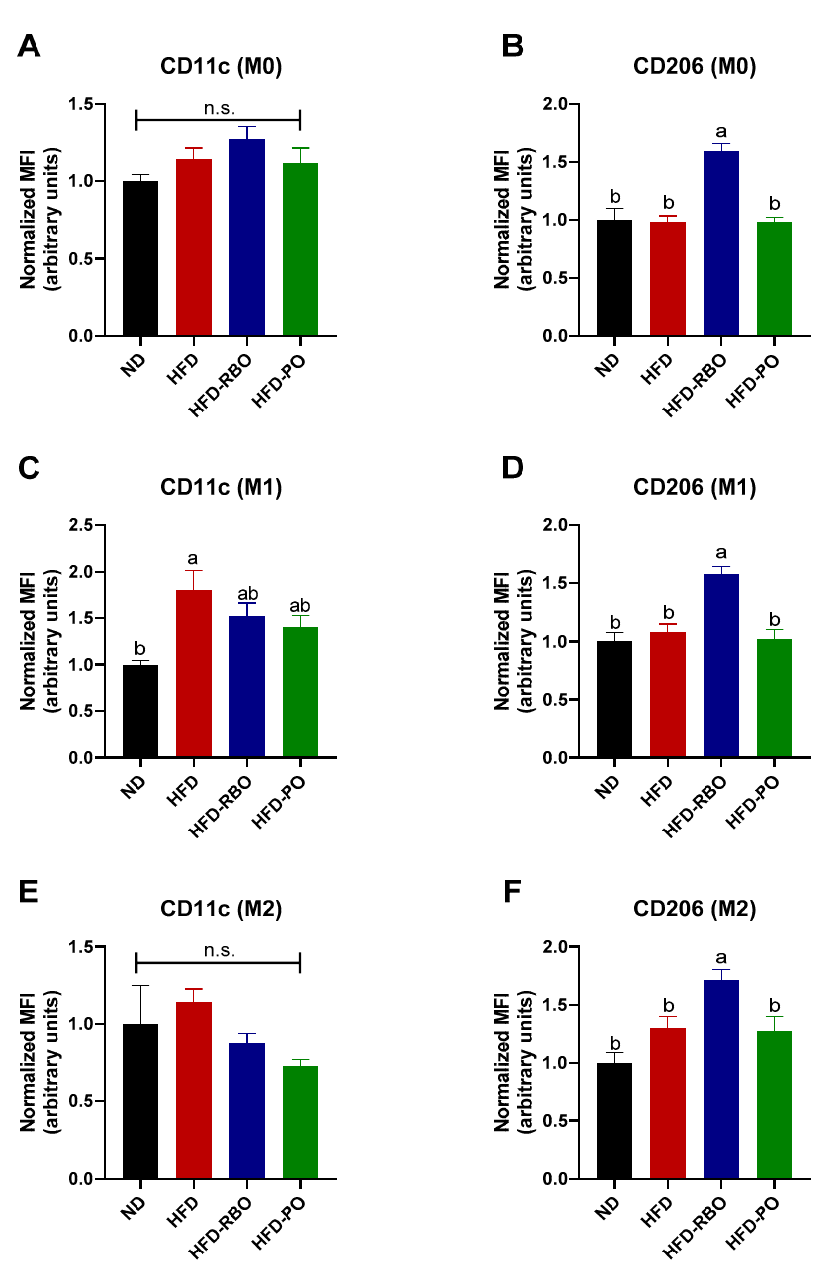
Figure 4. Expression of macrophage polarization markers in BMDMs. The BMDMs were stained with specific antibodies and mean fluorescence intensity (MFI) was assessed by flow cytometry. The F4/80 + CD11b + population cells were gated and designated as macrophages. The expression of ( A , C , E ) CD11c as an M1 marker and ( B , D , F ) CD206 as an M2 marker was further assessed in non-polarized (M0), polarized M1 BMDMs, and M2 BMDMs. Results were normalized to the MFI of the ND-fed control. n.s. no significance. Values are expressed as means ± SEM, and different letters indicate statistical significance ( p < 0.05) (ND, normal diet; HFD, high fat diet; HFD-RBO, high-fat diet-rice bran oil; HFD-PO, high-fat diet-palm oil).